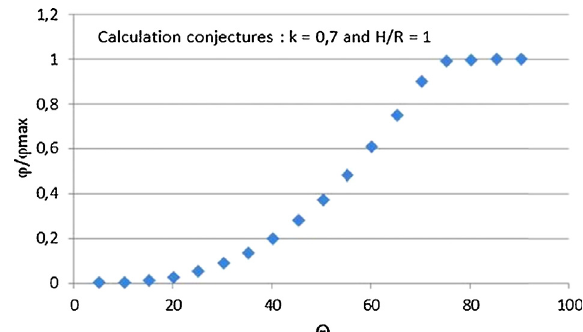
Fig. A.1 The lateral local heat flux distribution for a oxide corium pool from BALI